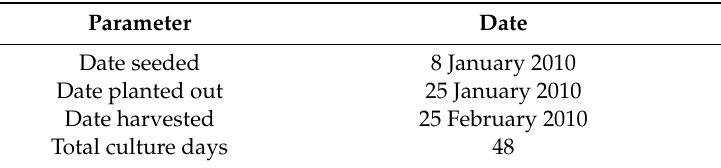
Table 1. Growth period parameters for hydroponic vs. 2010. —summer